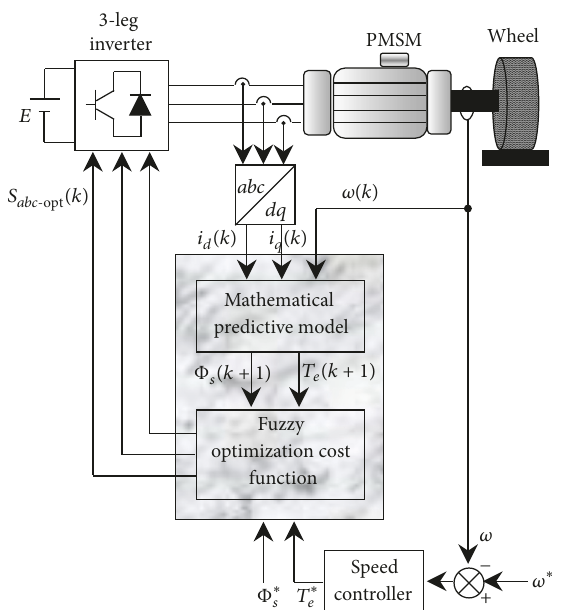
Figure 5: Block diagram of the proposed NMP-DTC